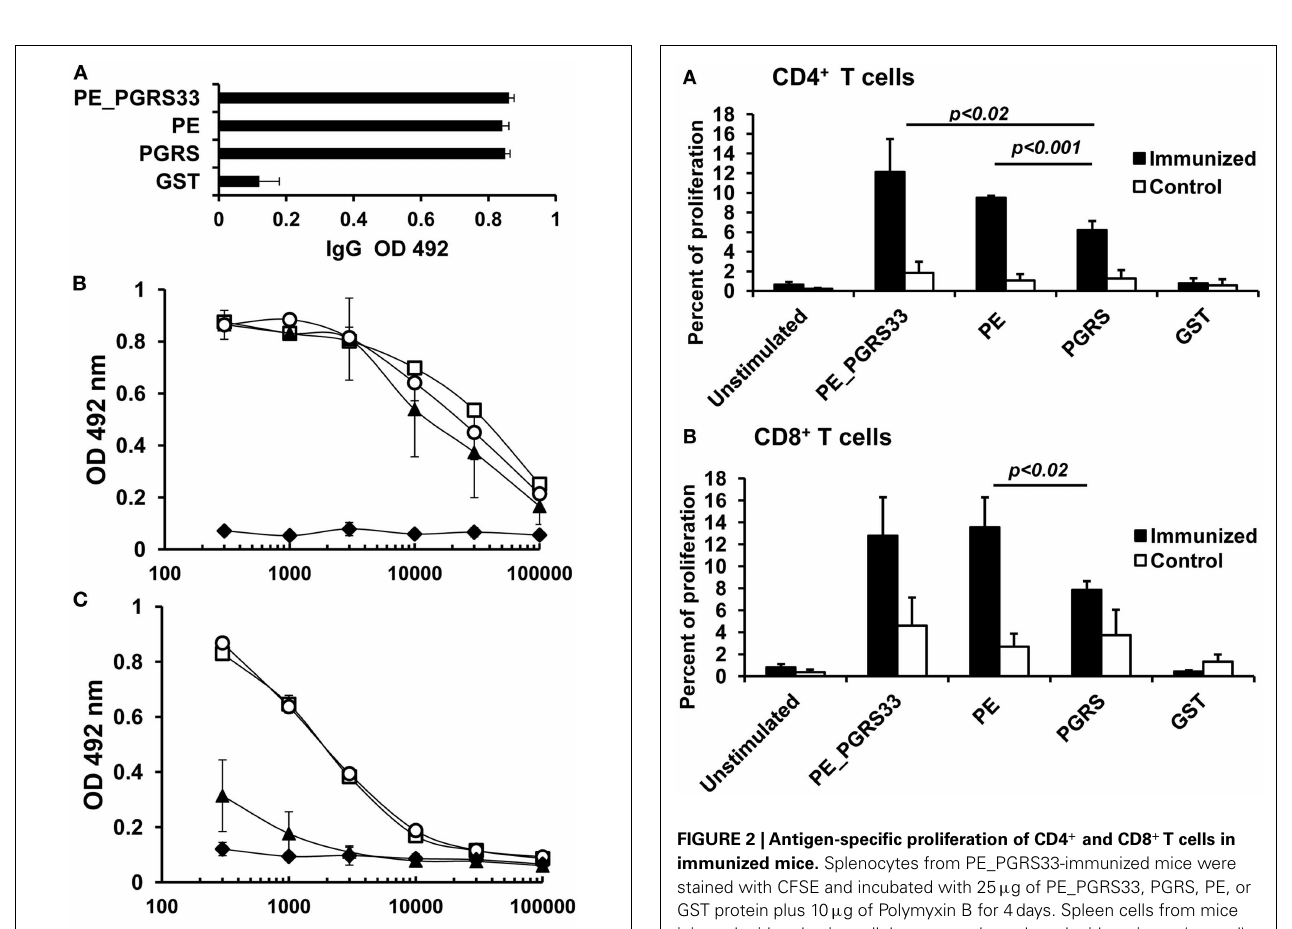
tuberculosis infection.